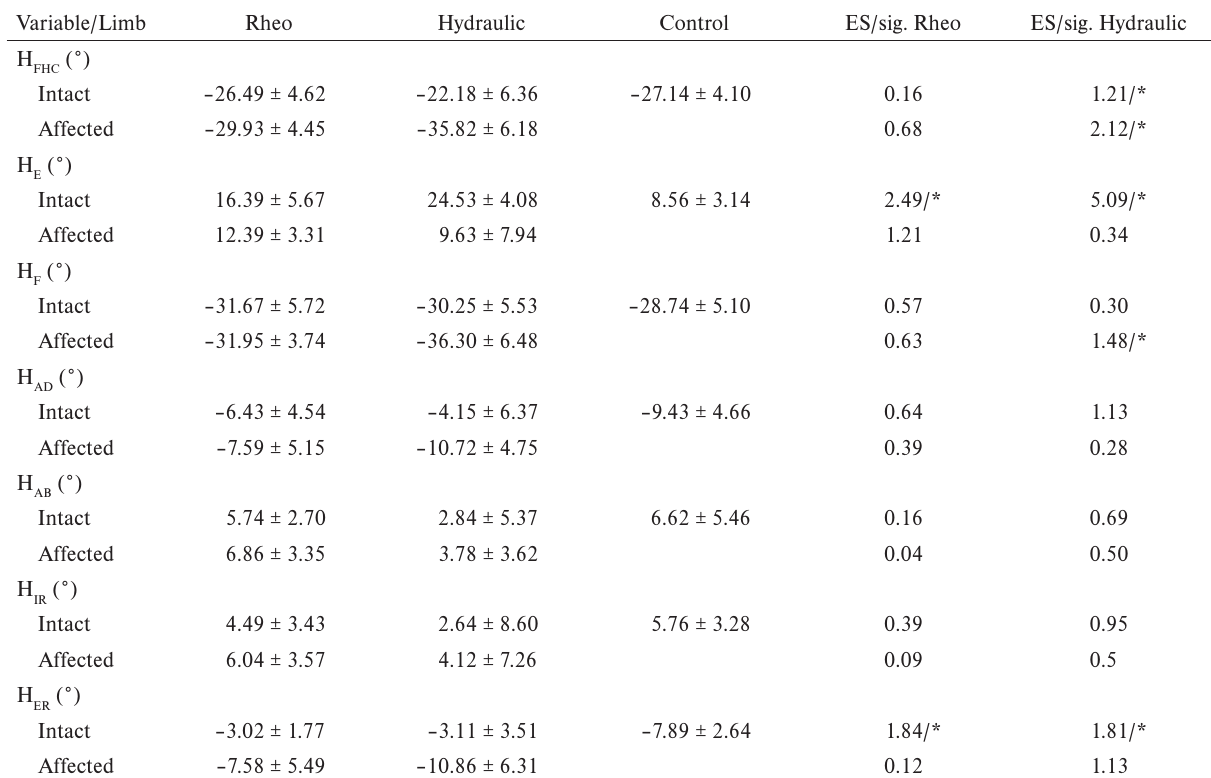
Comparison of angle parameters in the hip joint during gait of patients with bionic knee joints (Rheo), patients with hydrau- lic knee joints (Hydraulic) and the control group (Control)